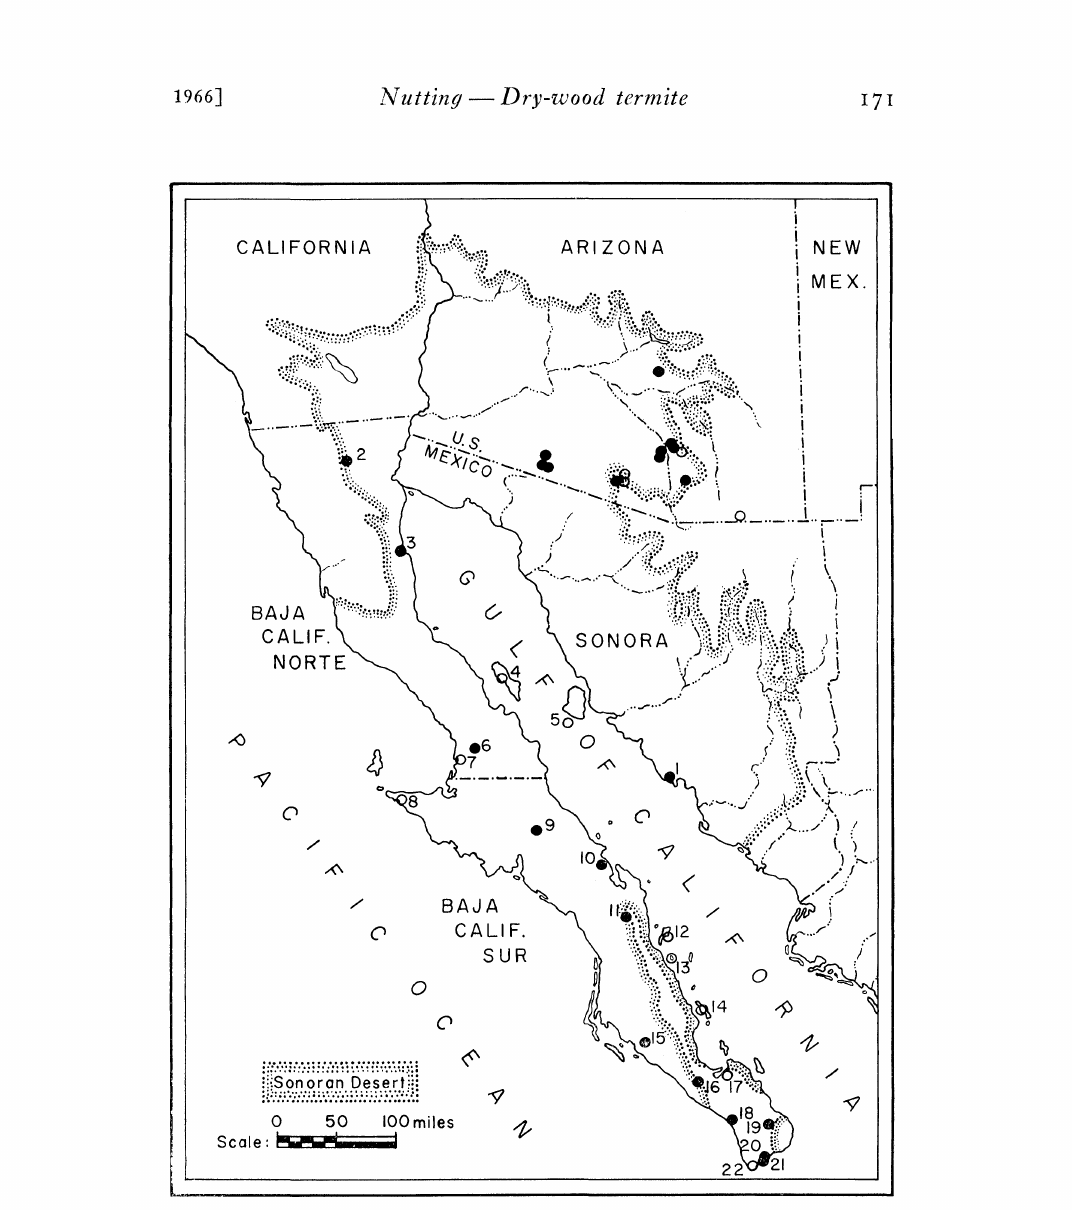
Figure 1. Map of the Sonoran Desert showing distribution of Pterotermes occidentis" open circles, previous records; solid circles, new records. See Table for key to numbered localities in